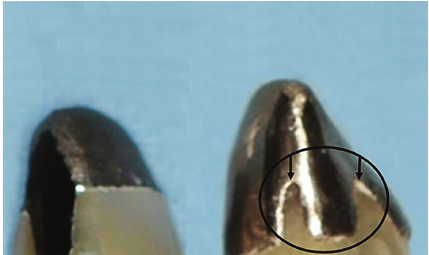
Figure 8: Illustration of the incomplete seating of post and cores in group 2.